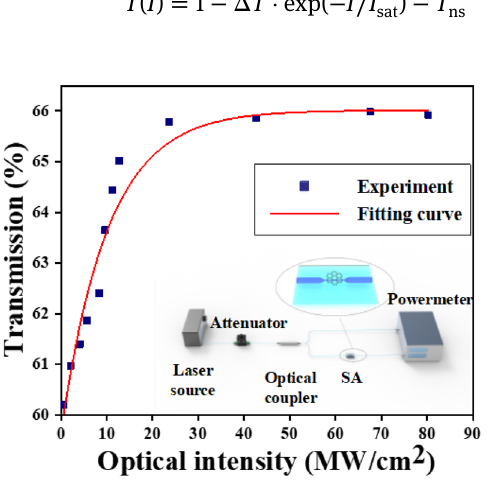
Figure 2: Nonlinear absorption curve of the Cr experimental setup of testing nonlinear optical property. Figure 3: The experimental setup based on Cr